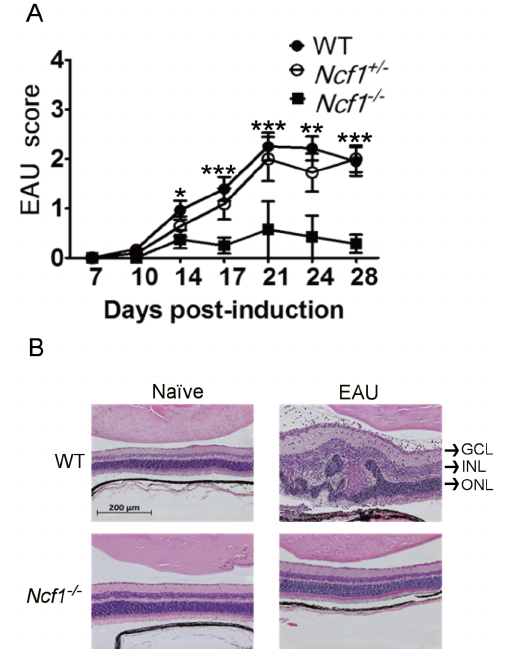
Figure 2. Absence of Ncf1 reduces EAU severity in mice. ( A ) Disease scores of wild-type mice (WT, n = 20), Ncf1 +/- mice ( n = 4), and Ncf1 -/- mice ( n = 20) after EAU induction are shown. Data show the mean ± SE values (error bars). * p < 0.05, ** p < 0.005, *** p < 0.001 compared with the Ncf1 -/- mice at the same time point. ( B ) Eyes of WT and Ncf1 -/- mice without (naïve) or with EAU induction were subjected to H&E staining. The retina portion is shown. Images are representative of at least four samples per group from two independent experiments. GCL, ganglion cell layer; INL, inner nuclear layer; ONL, outer nuclear layer. 2.1.3. The Influence of Ncf1 Deficiency on the Levels of Inflammatory Mediators in the Retinas of Mice with EAU Induction Both EAU and ROS can amplify the expression of cytokines and chemokines to affect EAU severity. We investigated the influence of EAU and Ncf1 deficiency on the expression of cytokines and chemokines in the mouse retina. Cytokines (interleukin (IL)-1β, interferon (IFN)-γ, and tumor necrosis factor (TNF)-α) can promote the ROS response [26]. During EAU, leukocytes, macrophages and T lymphocytes can infiltrate the retina [10]. Monocyte chemoattractant protein (MCP)-1 is a chemokine capable of recruiting both macrophages and lymphocytes [27]. Th1, Th2, and Th17 responses regulate EAU [28]. We therefore assessed MCP-1, Th1 cytokines (IFN-γ and IL-12), Th2 cytokines (IL-4 and IL-6), and Th17 cytokines. EAU induction increased the levels of cytokines